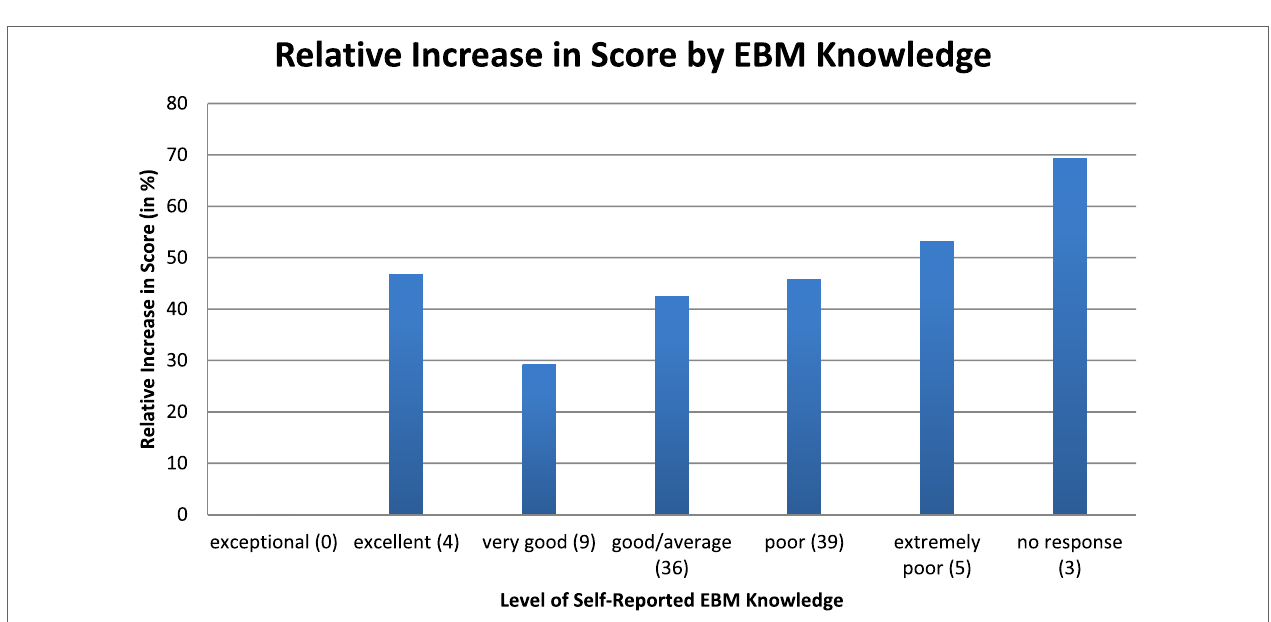
FigUre 3 | Relative increase in scores from pre-course to post-course questionnaire by level of self-reported evidence-based medicine (EBM)